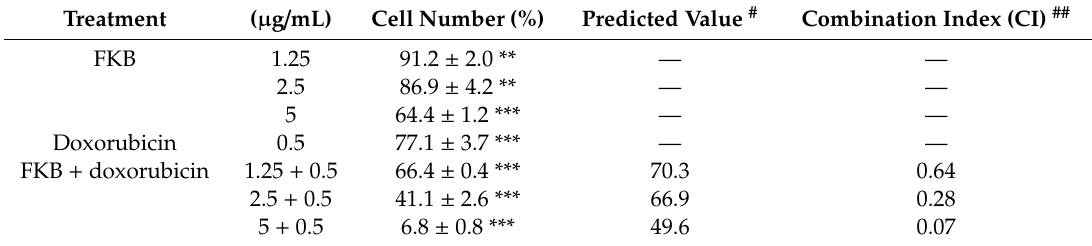
Table 1. The synergism e ff ects of FKB and doxorubicin on AGS